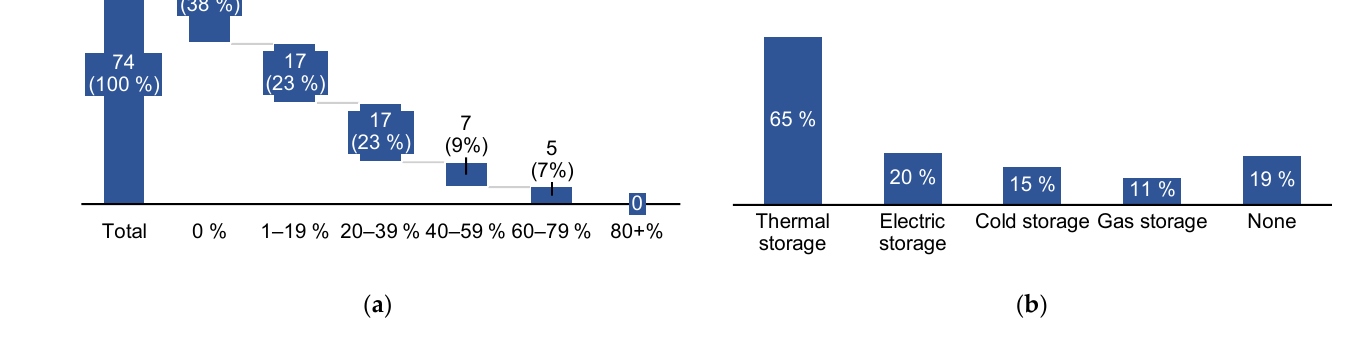
Figure 3. ( a ) Share of on-farm electricity utilization in 2021 across the sample; ( b ) Installed energy storage systems at the sample farms.